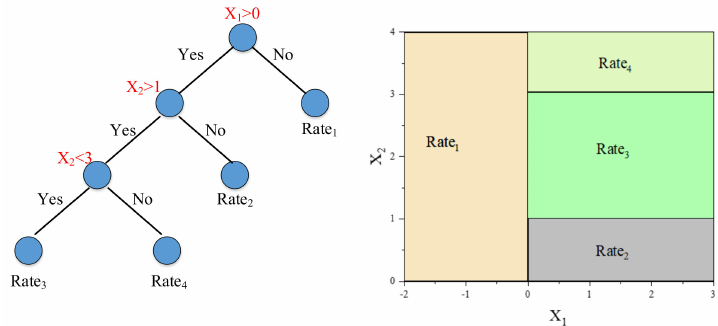
Figure 3. An example of a single Classification and Regression Tree (CART) model.